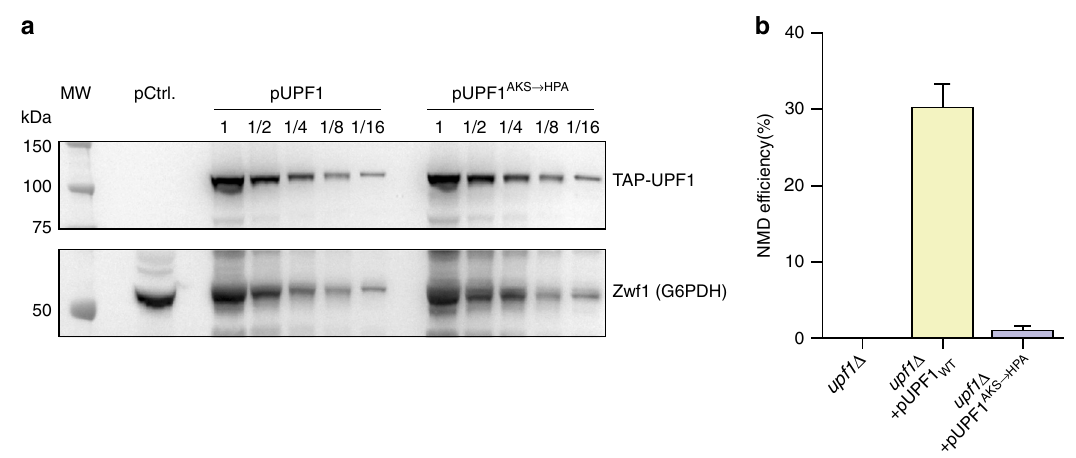
Fig. 5 Loss of UPF1 processivity reduces NMD ef fi ciency. a The levels of the expressed proteins, as tested with antibodies against the N-terminal TAP tag, were similar for UPF1 and UPF1 AKS → HPA , showing that the reduction in NMD ef fi ciency is due to the mutation and not to a reduction in UPF1 expression levels. Two-fold dilutions of protein extracts were separated on 4 – 12% polyacrylamide gels, transferred and probed. The signal for an abundant protein, Zwf1, was used as loading control. b To test the ability of the UPF1 AKS → HPA variant to function in vivo in NMD, we used RT-QPCR to measure the steady- state levels of a natural NMD substrate, the transcript for the DAL7 gene. A upf1 Δ strain was transformed with a control plasmid (pRS316), a plasmid expressing a region encompassing UPF1 helicase domain, and a plasmid expressing a mutant version (UPF1 AKS → HPA ) and compared with a wild-type (WT) strain transformed with the control plasmid. The changes in DAL7 RNA levels compared with wild-type were measured in three independent experiments and used to calculate NMD ef fi ciency, with average and standard deviation values shown as a bar